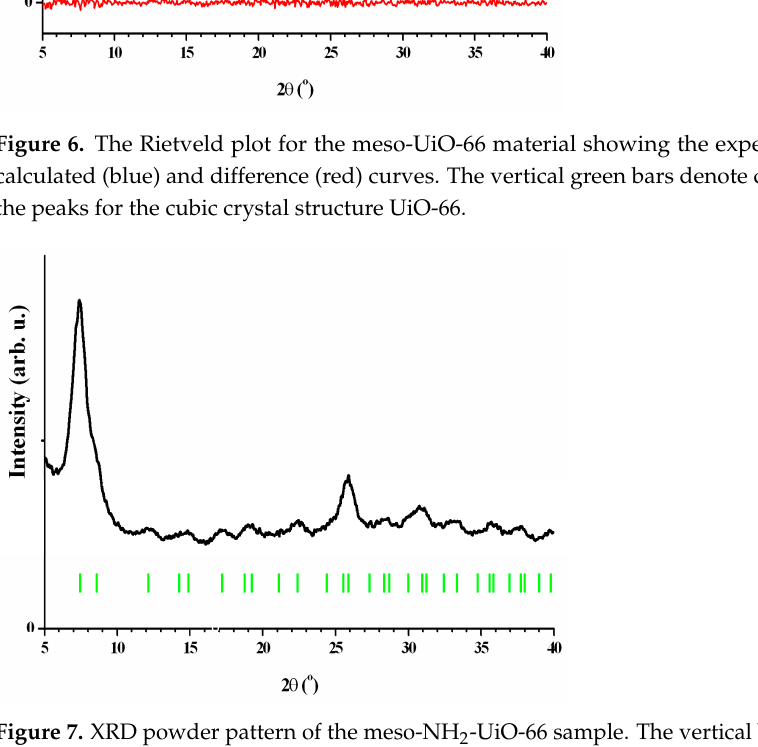
Figure 7. XRD powder pattern of the meso-NH 2 -UiO-66 sample. The vertical bars denote calculated positions of the peaks for the cubic crystal structure UiO-66.